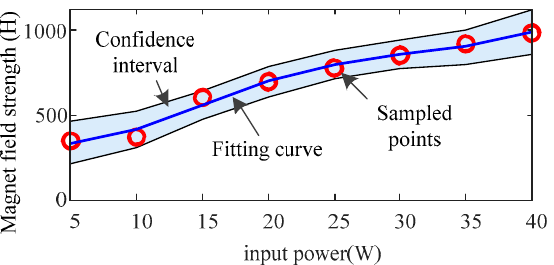
Figure 20. Fitting curve and its confidence interval of different input powers.